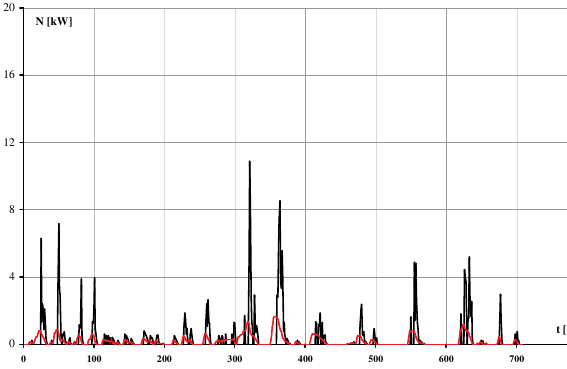
Fig. 6. The kinetic power (black color) and resistance power (red color) of the movement at the lightest traffic